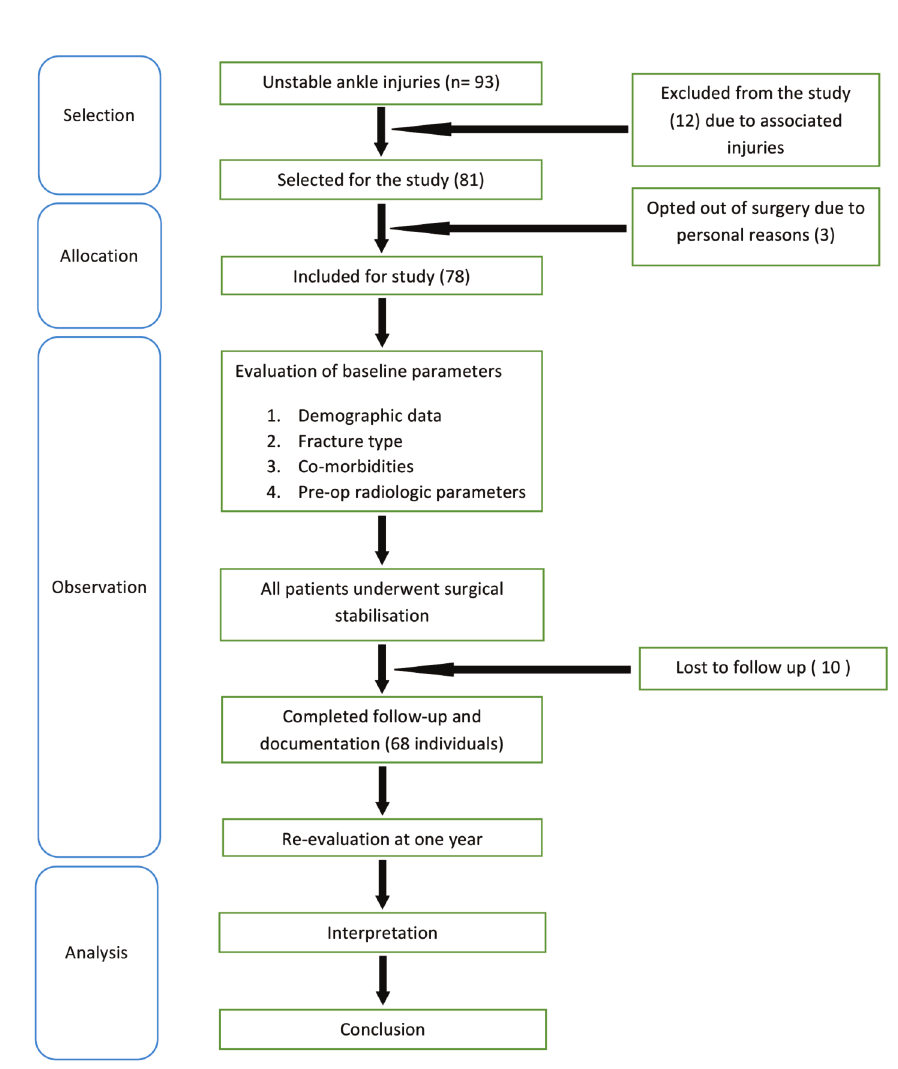
Flowchart showing study methodology. Fig. 1: